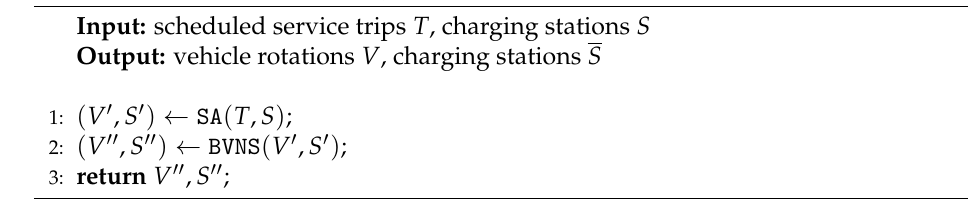
Algorithm 1 Main Variable Neighborhood